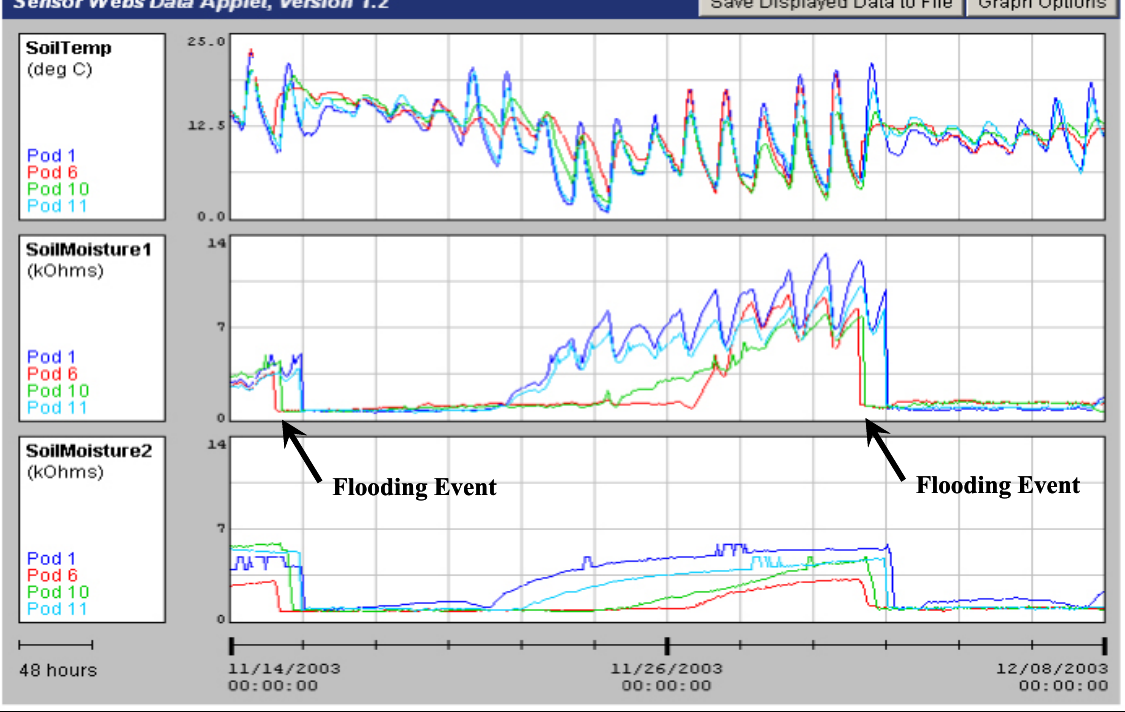
Figure 7. Screen-capture of Internet data from CAVSARP facility. Graphs (top to bottom): surface temperature ( ◦ C), surface moisture, and soil moisture at 0.5 m depth (relative units; lower values imply wetter soil). Diurnal cycles in soil water potential measurements are largely artifacts that can be corrected using the soil temperature at the same location and depth. Sensor Web pod 1 (southwest basin corner) is in blue, pod 6 (basin inlet, northwest corner) in red, pod 10 (basin center) in green, pod 11 (southeast basin corner, diagonal from pod 6) in light blue. Data correlate with water discharge into basin, inundation, infiltration, drying, and the beginning of another